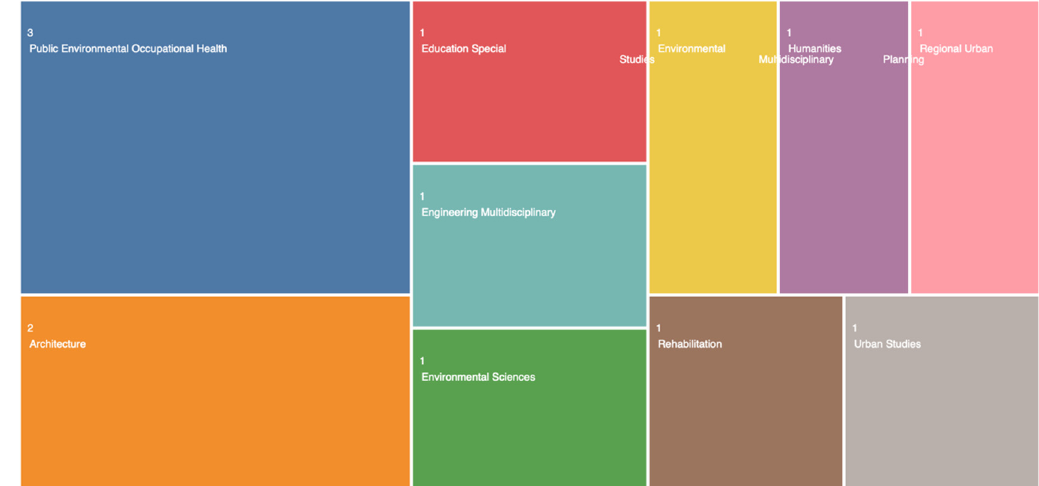
Figure 3. Data visualization scheme based on manuscript relevancy. Table 2. WoS papers published in the years 2014–2022.